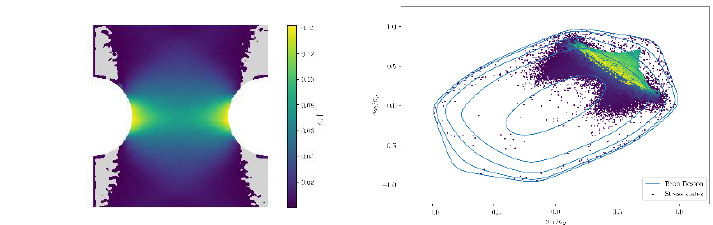
Fig. 6. Cumulated plastic strain field and stress states for the notched specimen computed from DIC